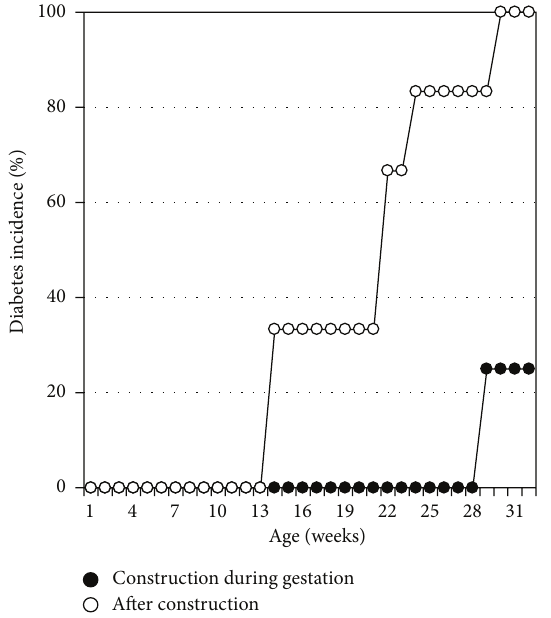
Figure3:Nearbyconstructionaffectsdiabetesonsetandcumulative incidence in NOD mice born from the same breeder pair. The cumulative incidence of diabetes is compared for female NOD mice born from the same breeder pair at different times, namely, those who nearby construction occurred during their embryonic development (closed circles, n = 4) and those born over two months after the construction event (open circles, n = 6). Log-rank test, P value <